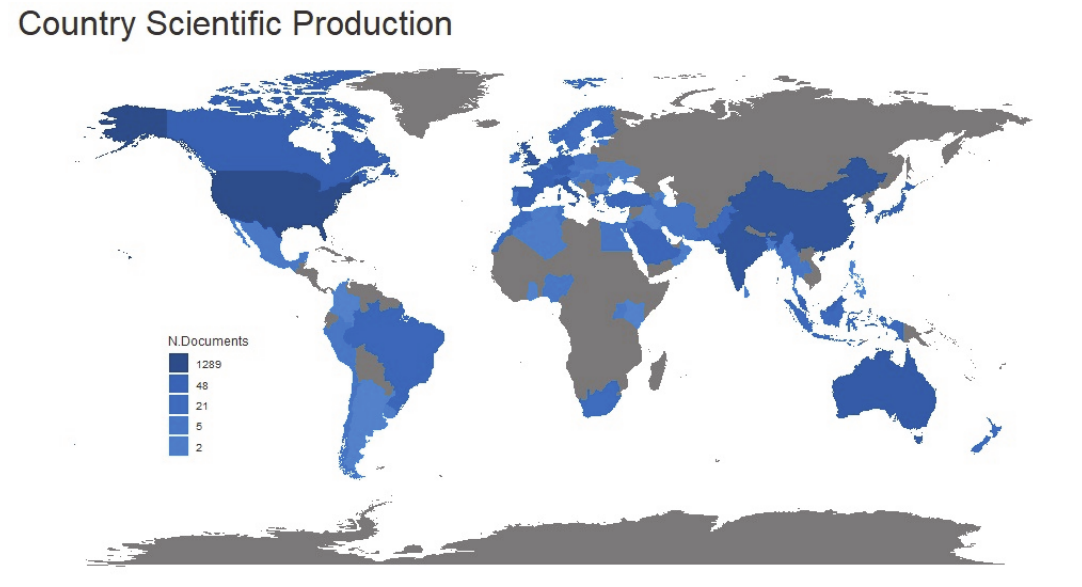
Fig. 2. The frequency of the keywords used in different big data in social media